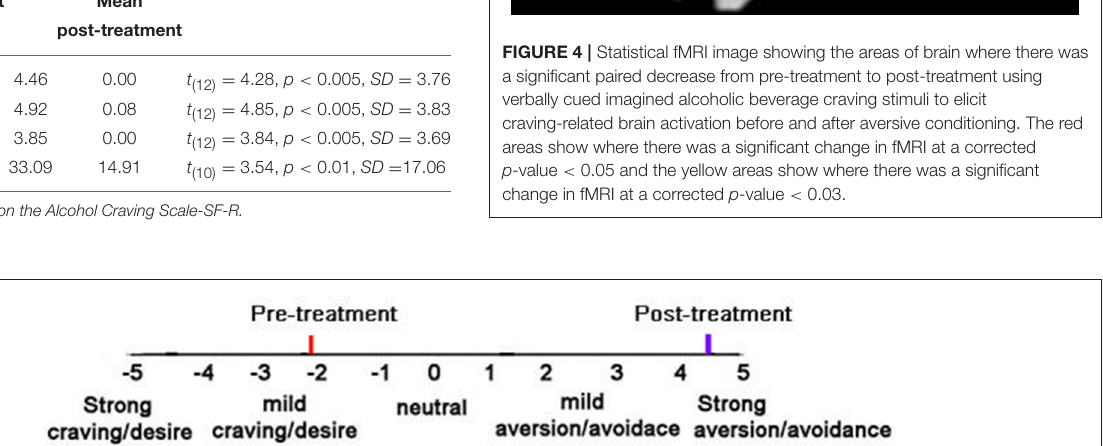
Frontiers in Behavioral Neuroscience |